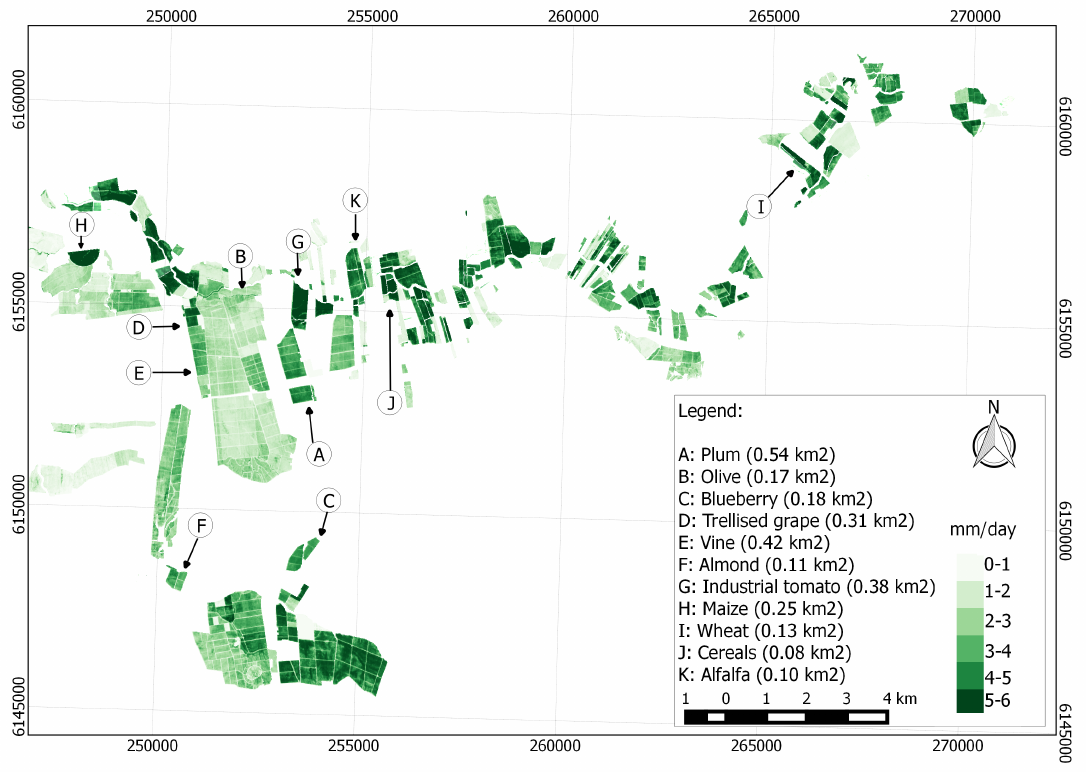
Figure 7. Identification of the selected orchards and annual crops to show the behavior of daily (cid:100) ET c during the analyzed